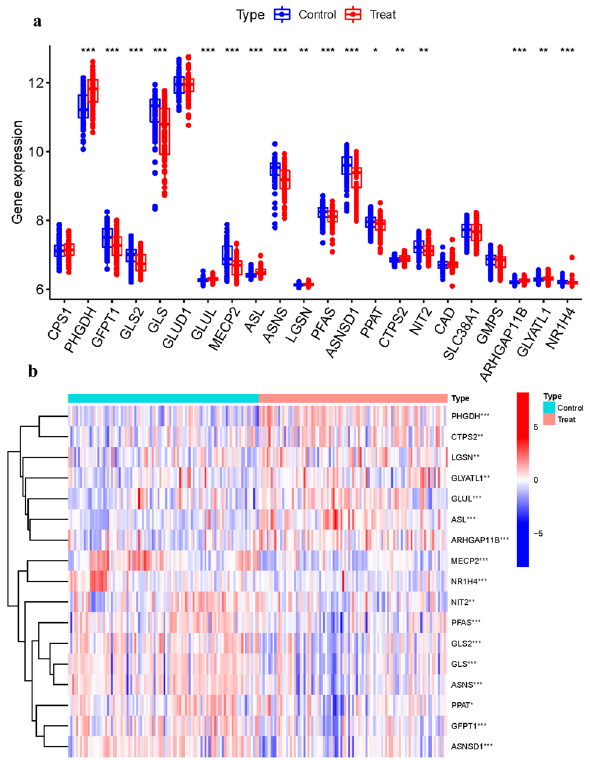
Figure 2. Principal component analysis. ( a ) GlnMgs. ( b ) Expression of GlnMgs in